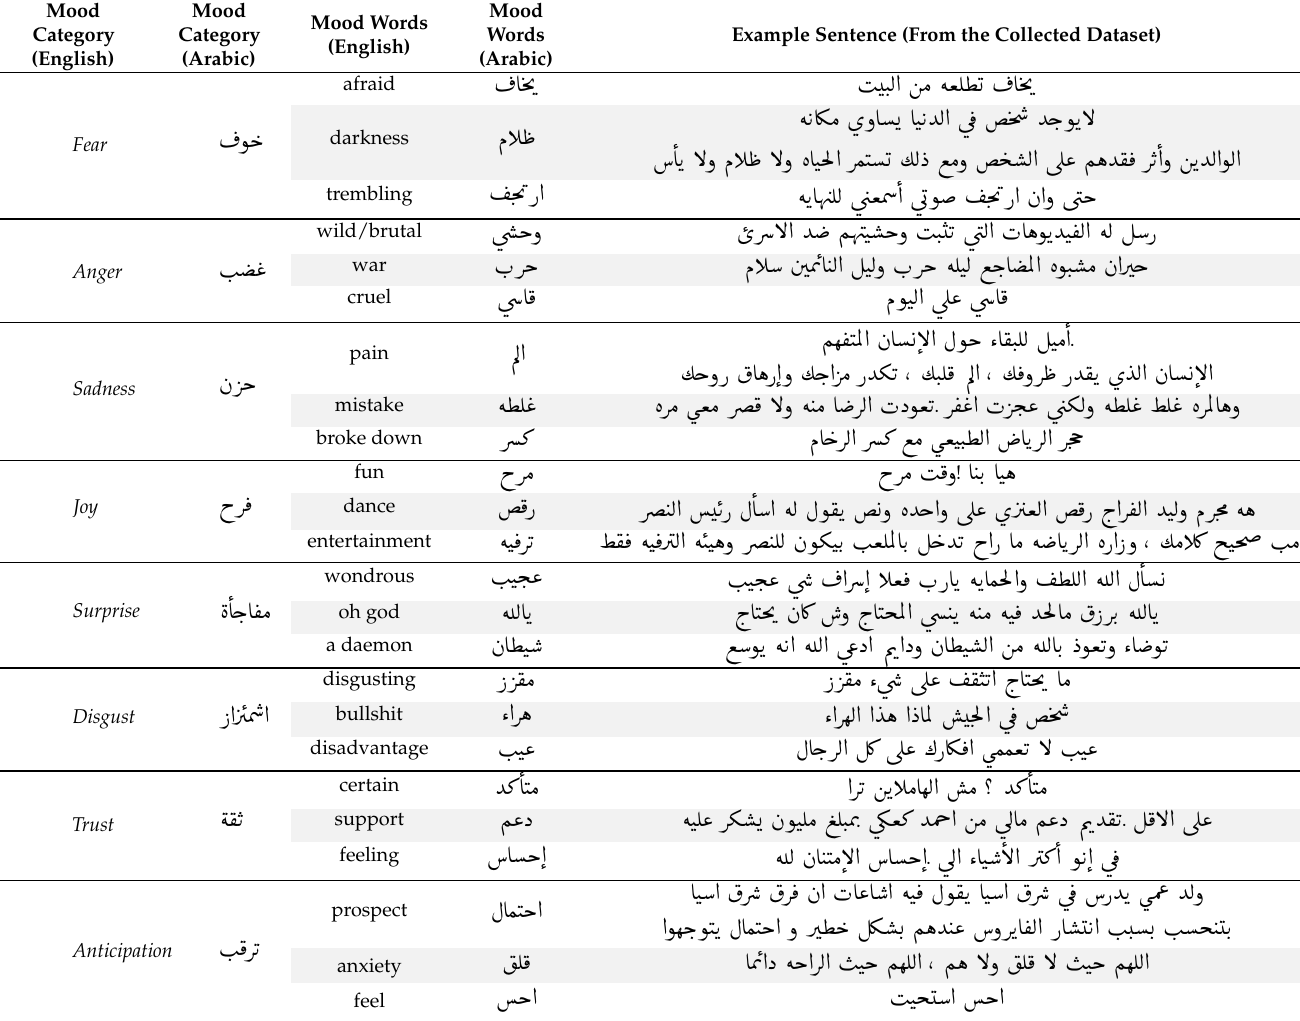
Table 5. Example of emotion words in